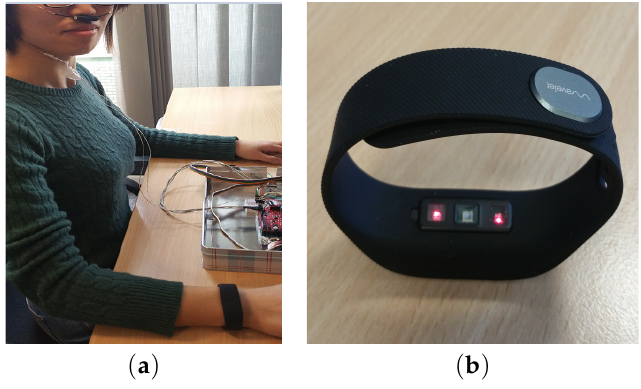
Figure 2. ( a ) A subject wearing the commercial Wavelet Health sensor. A thermocouple is used to provide ground-truth data for breath-by-breath respiration. ( b ) The Wavelet Health